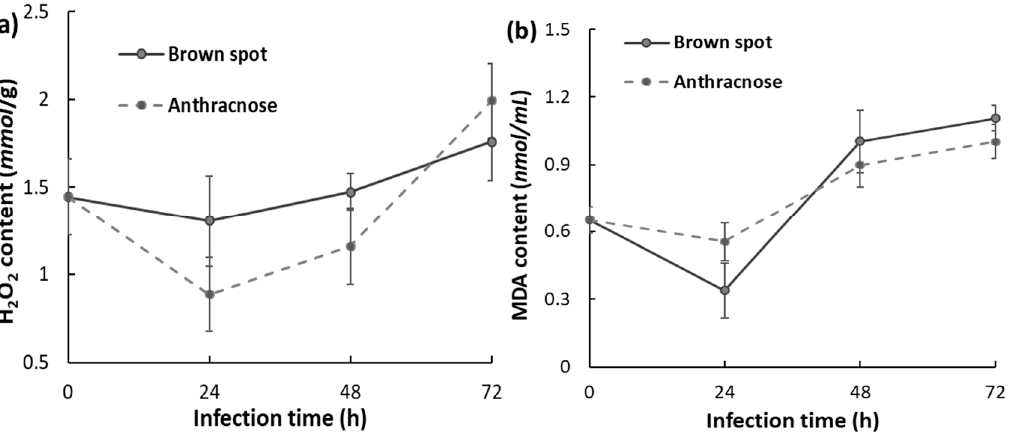
Figure 3. Effects of fungal infection on contents of H 2 O 2 ( a ) and MDA ( b ) in cucumber leaves. Data were expressed as the mean of three replicates ± standard deviation.